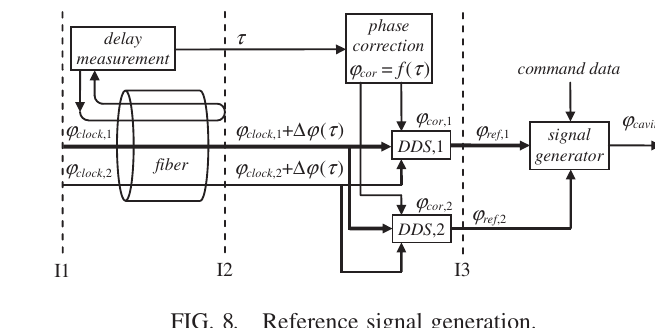
FIG. 8. Reference signal generation.